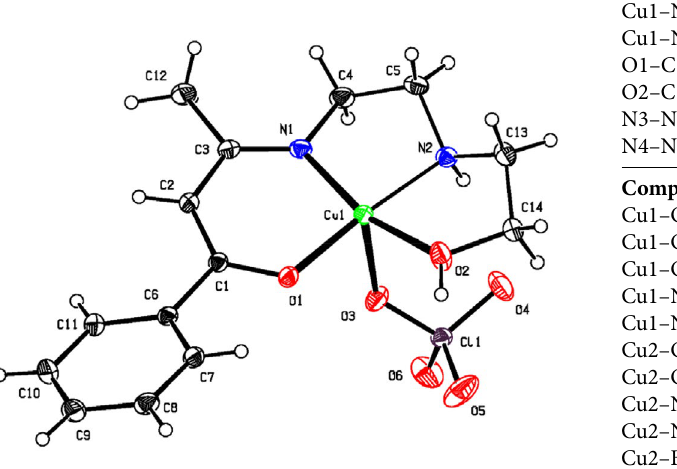
Fig. 1. The molecular structure of [CuL(ClO 4 )], 1 with labeling of selected atoms.